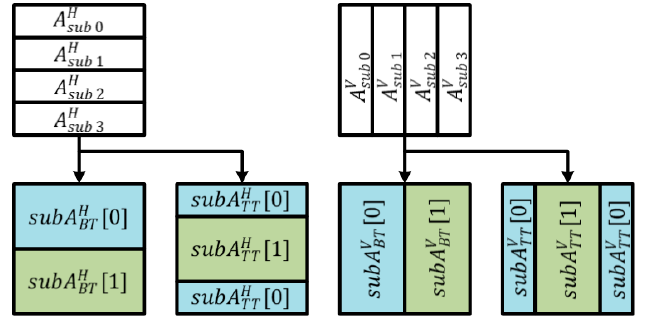
Figure 7. Example of sub-activities.